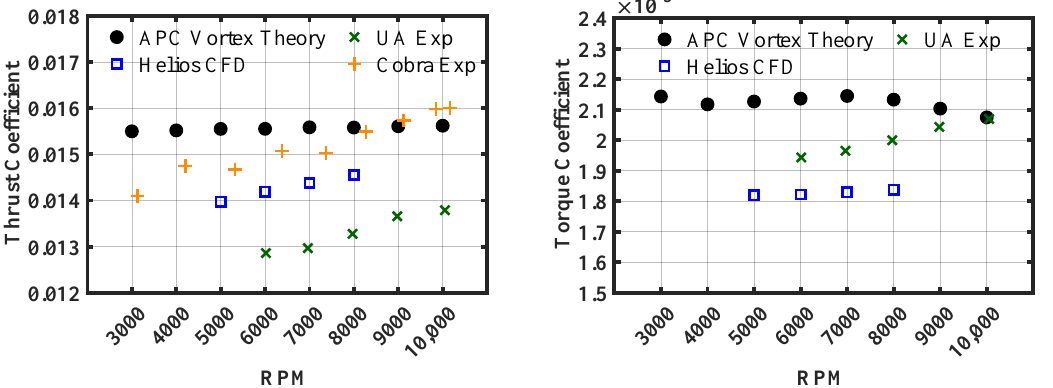
Figure 7. A collection of measured and computed thrust coefficient and torque coefficient values for the APC8x4.5-MR rotor in hover.